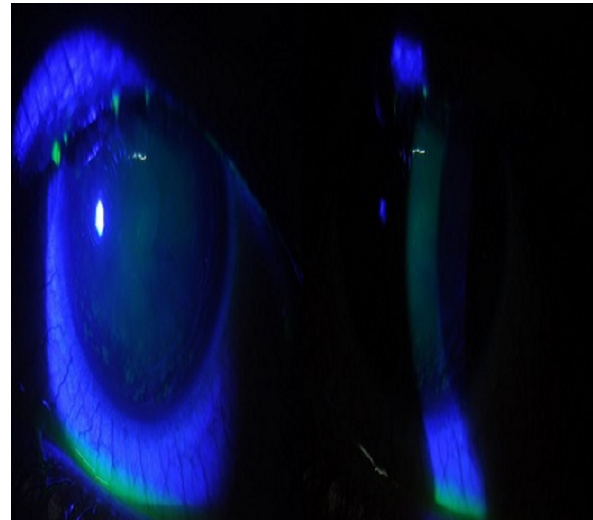
Figure 2: Slit lamp photo of the left eye showing corneal punctuate epithelial erosions, abrasions, and loose epithelium